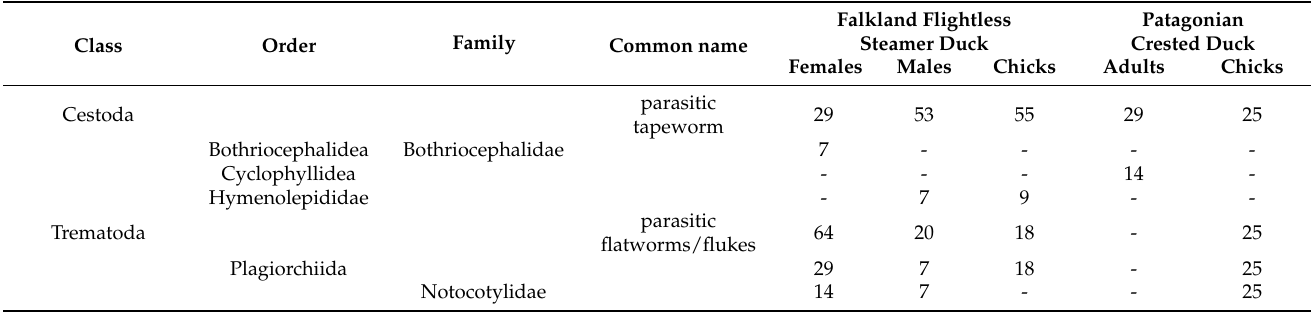
Figure 2. Differences in diet composition among Falkland Flightless Steamer Duck Tachyeres brachy- dactyla age and sex categories. Data correspond to individuals foraging on the coast of New Island, Falkland/Malvinas Islands, from October 2017 to February 2019. We used non − metric multidi- mensional scaling of molecular operational taxonomic units to collapse information from multiple dimensions into two dimensions to facilitate visualization and interpretation. The ellipses and lines connect similar categories. Table 4. Platyelminthes detected in Falkland Flightless Steamer Duck Tachyeres brachydactyla and Patagonian Crested Duck Lophonetta specularoides , and frequency of occurrence (% of samples).